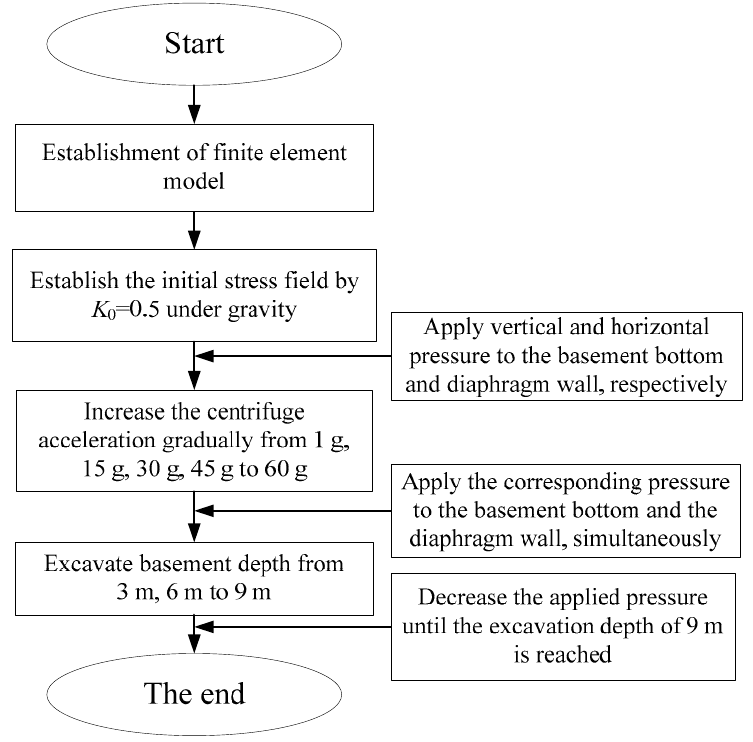
Figure 4. A sketch of the modeling procedure.